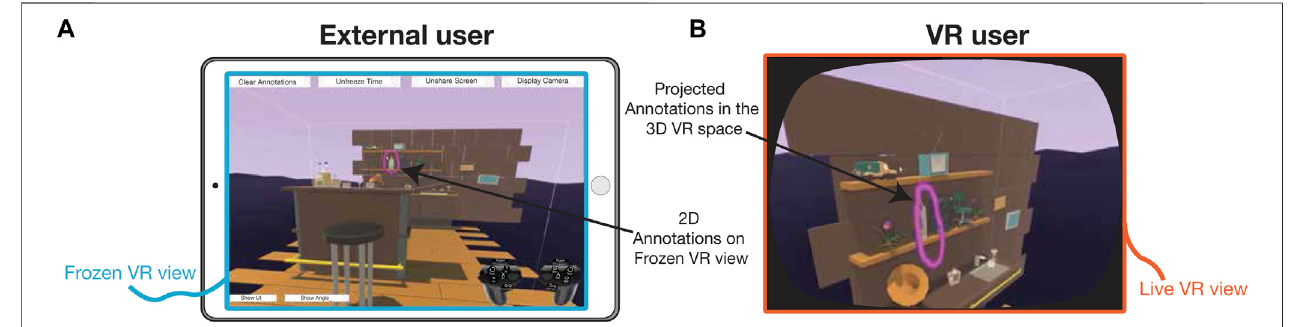
FIGURE 12| (A) : Annotations made over a2D video for referring toan object in the VR space; (B) : Correspondingannotations projected to the right 3D position in the VR space.